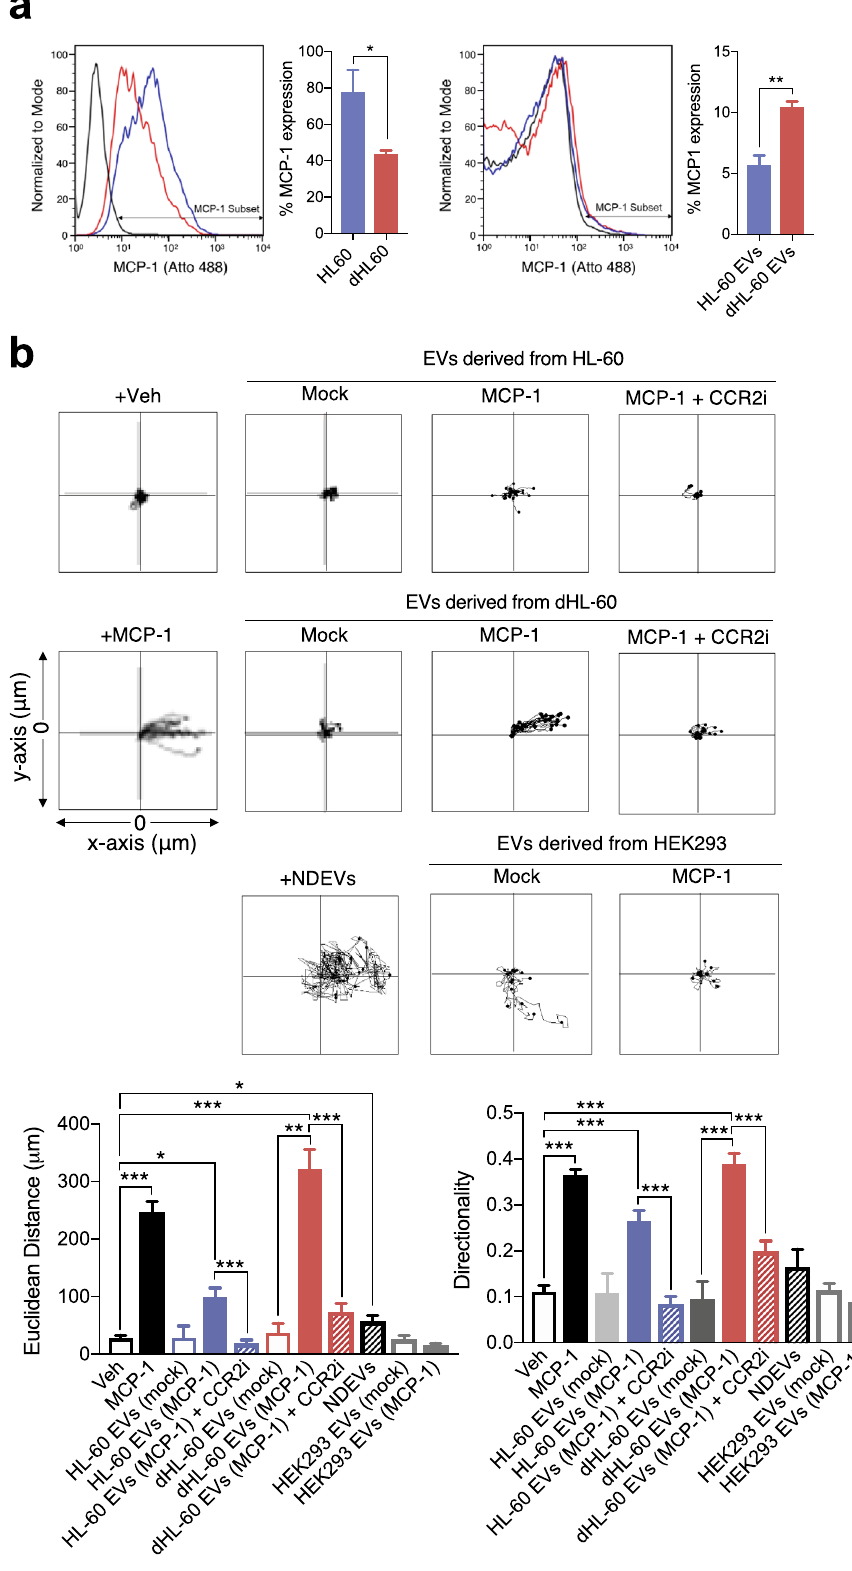
Figure 3. The delivery of MCP-1 using dHL-60 cell-derived EVs. ( a ) Left panels, fluorescence levels of MCP-1 in the HL-60 and dHL-60 cells. Right panels, fluorescence levels of MCP-1 in EVs derived from the HL-60 and dHL-60 cells. ( b ) Monocyte migration tracking analysis against EVs. Bar graphs denote Euclidean distance and relative directionality. All data represent three independent experiments; mean ± SEM. *P < 0.05; **P < 0.01; ***P <